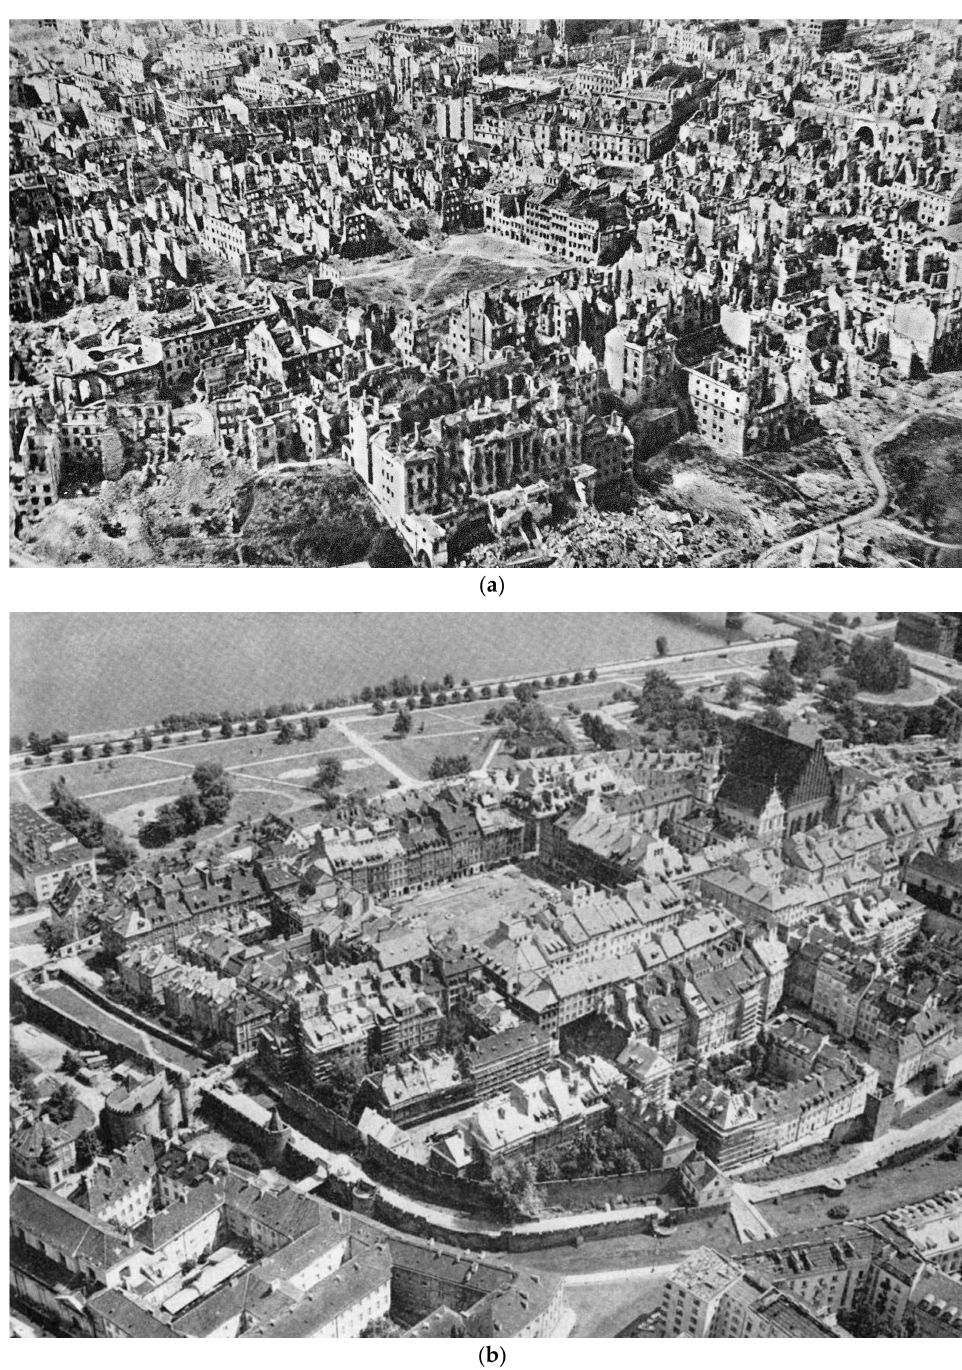
Figure 6. Warsaw Old Town ( a ) in 1945 (view from the East), in public domain, available online: https://commons.wikimedia.org/wiki/File:Warsaw_Old_Town_1945.jpg (accessed on 1 March 2018) and ( b ) its reconstruction 1950–1953 (view from the West), in public domain, after [24] (plate